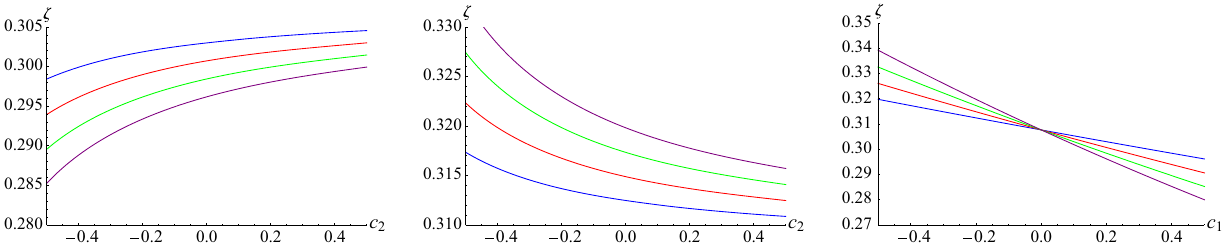
≡ ζ in terms of the cou- Fig. 11 Plots of the universal constant P c v c blue, red, green and purple curves correspond to k = 0 . 1, 0 . 15, 0 . 2, T c pling parameter c 1 or c 2 , for the different values of the characteristic 0 . 25, respectively. Left panel: c 1 = 0 . 1. Middle panel: c 1 = − 0 . 1. parameter k of the non-linear electrodynamics, at m = c = 1. The Right panel: c 2 =